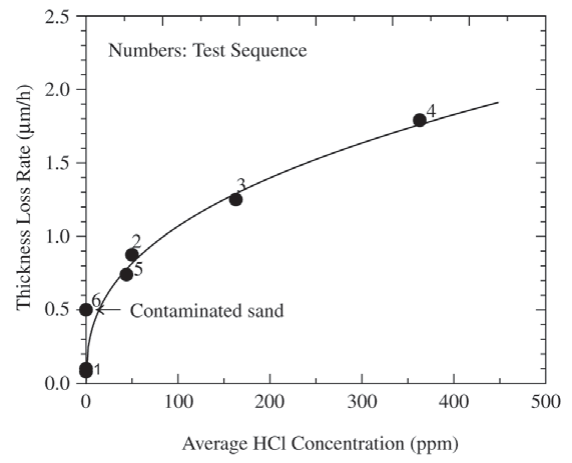
Figure 7. Effect of HCl on the maximum wastage rates as a func- tion of specimen temperature.